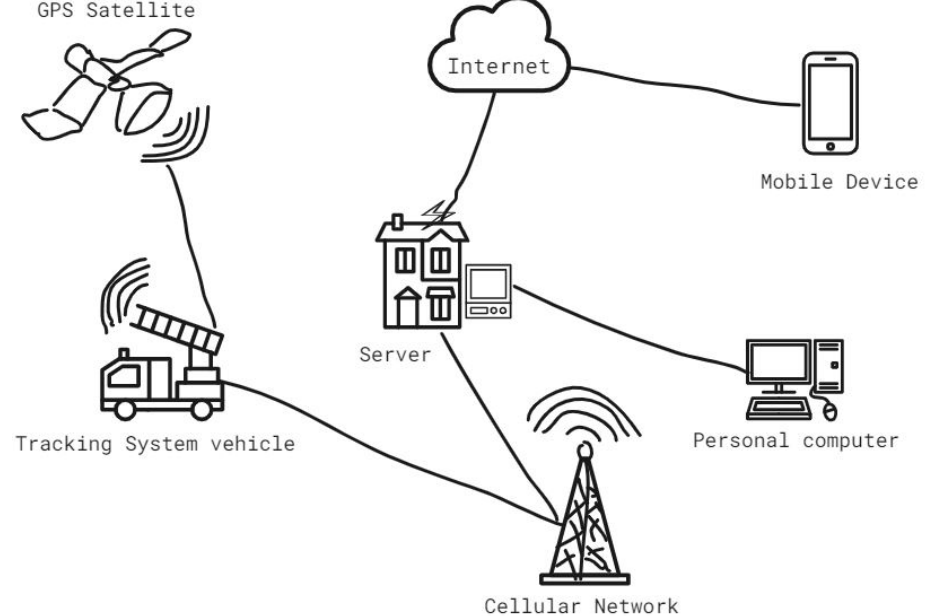
Figure 5. Real-time GPS tracker system.